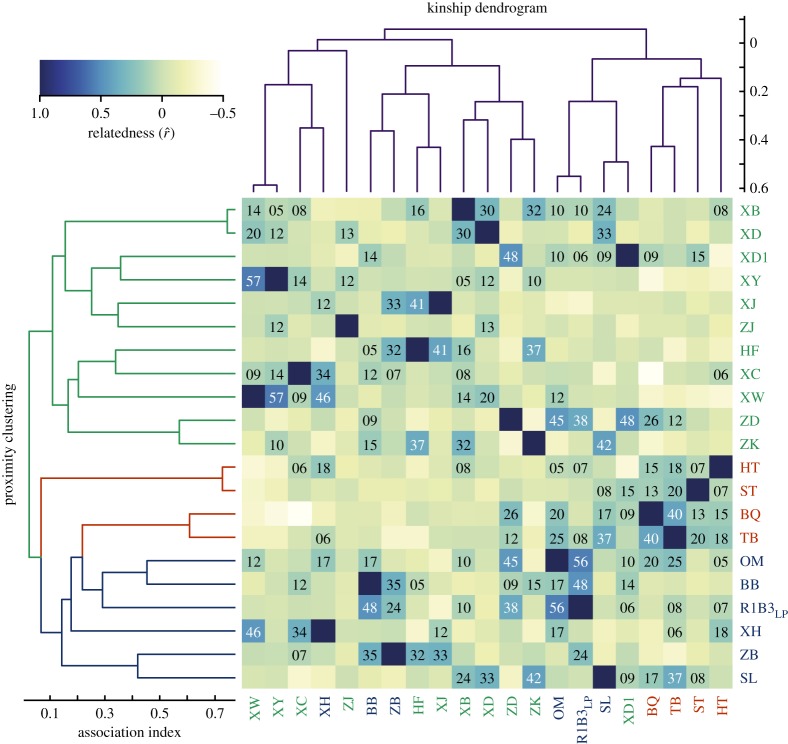
A heatmap of kinship among members of the GNG-AMB. Cell colours denote the values of the estimated relatedness coefficients. The number inside a cell represents the estimated relatedness coefficient (values > 0) and is shown as the coefficient value × 100. The two dendrograms identify the strength of proximity associations (left) and pairwise relatedness (top). Text colour (right and bottom) distinguishes members of the three AMUs obtained from the proximity data.